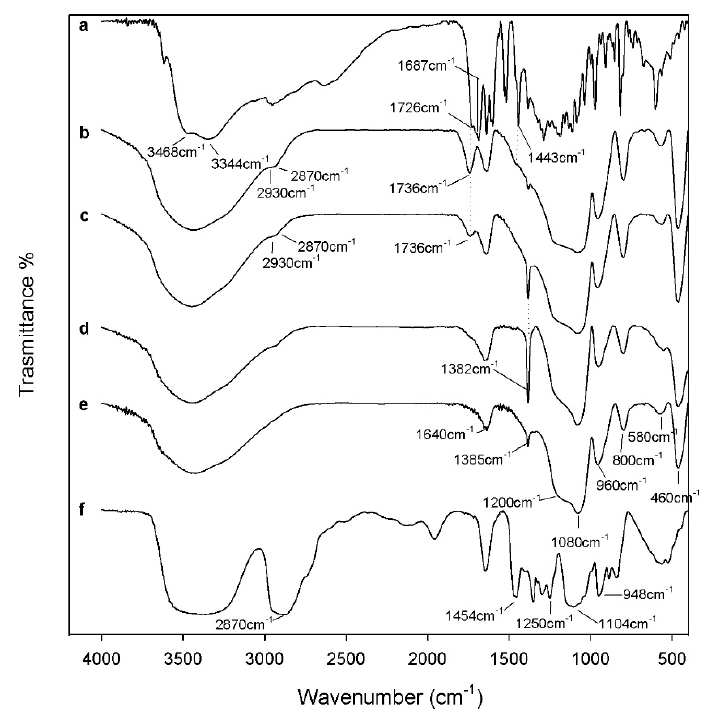
Figure 2. Representative FT-IR spectra a. CGA; b. SiO 2 /PEG 6wt% /CGA 10wt% ; c. SiO 2 /PEG 6wt% /CGA 5wt% ; d. SiO 2 /PEG 6wt% ; e. SiO 2 ; f. PEG.